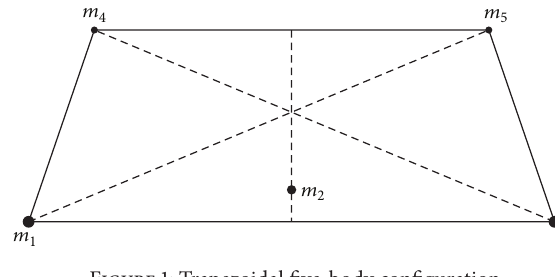
Figure 1: Trapezoidal five-body configuration.